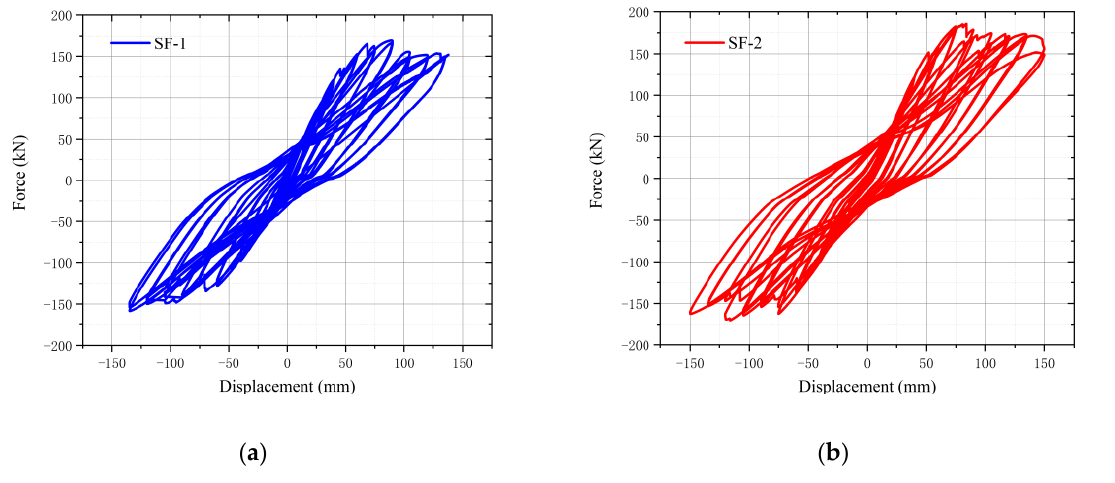
Figure 15. Hysteresis curves of SF-1 ( a ) and SF-2 ( b ).